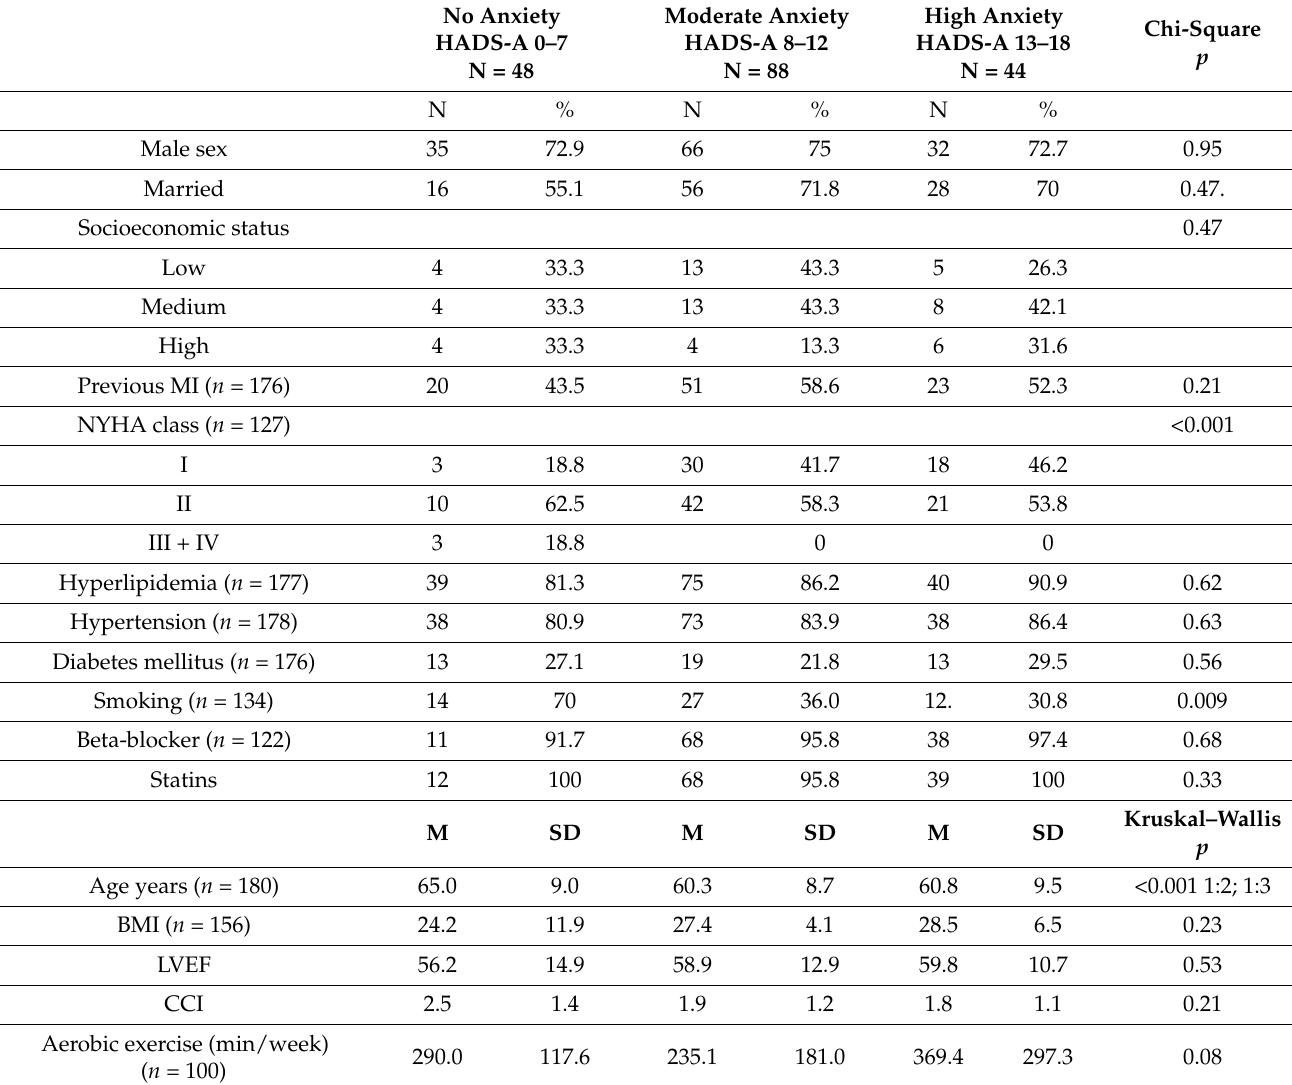
Table 1. Baseline characteristics in 180 CHD patients of this study.